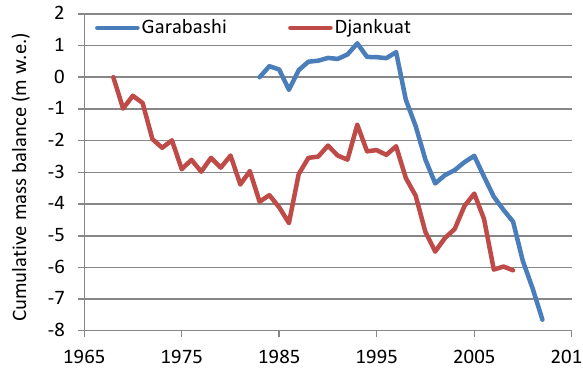
Figure 7. Cumulative mass balance of Garabashi and Djankuat glaciers (WGMS, 2013; unpublished records from the Institute of Geography, Russian Academy of Science for Garabashi in